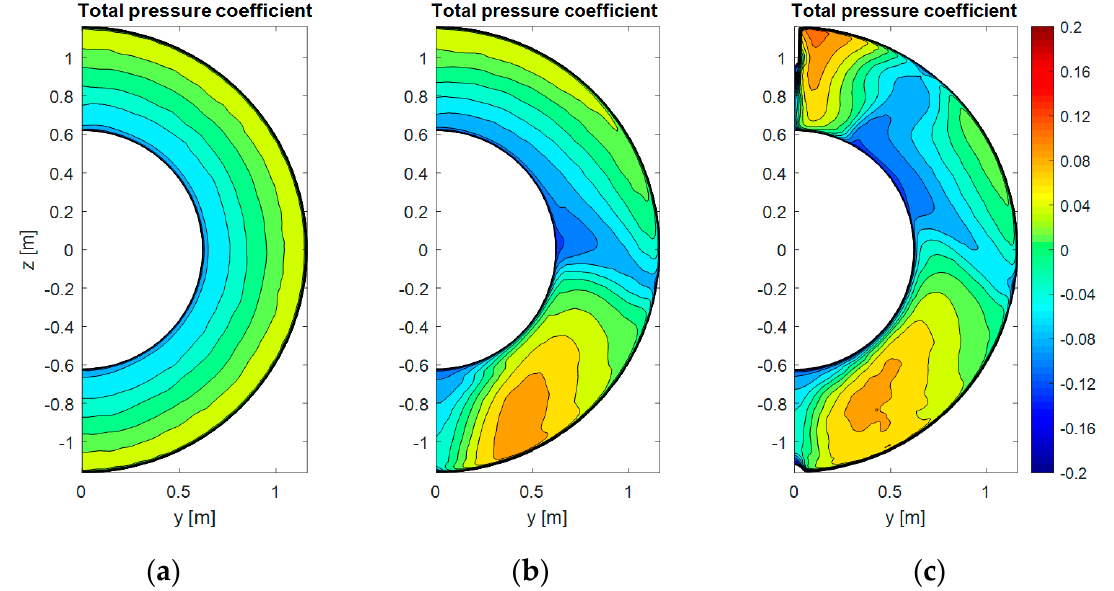
Figure 9. Contours of total pressure coefficient at the AIP. ( a ) bare PFC configuration, ( b ) bare PFC configuration + wing and ( c ) bare PFC configuration + wing + vertical tail (Source: [58]).